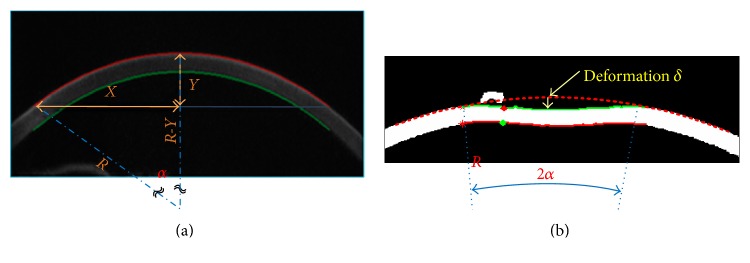
Images collected from the Corvis ST and the geometric relationship marked (a) before cornea deflection and (b) at the moment of maximum deflection.